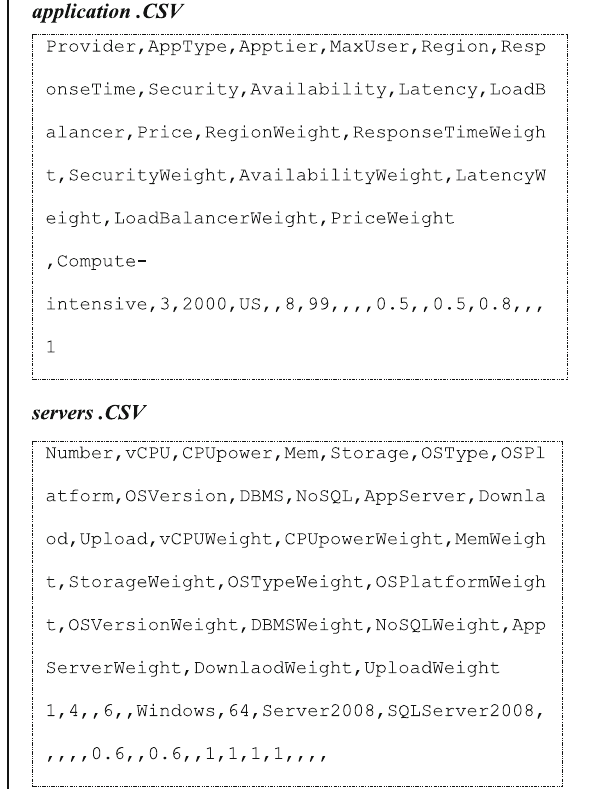
Fig. 6 The .csv files pertaining to server 1 of the application Fig. 7 Query for service search